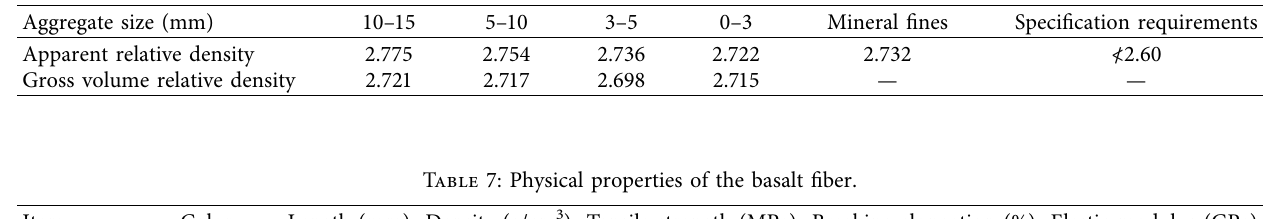
Table 6: Physical properties of the aggregate.